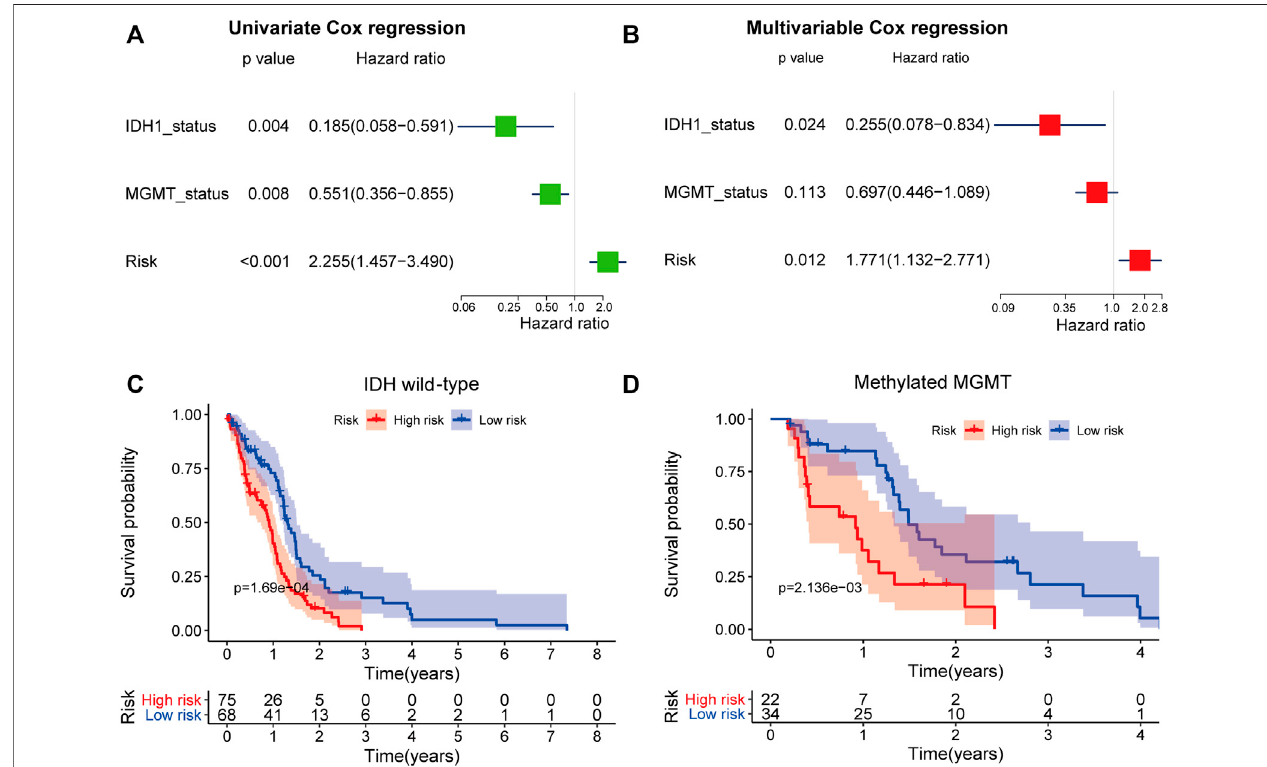
FIGURE 9 | The independence of the prognostic value of the fi ve-mRNA signature from molecular features. Univariate (A) and multivariate (B) Cox regression analysesofthecorrelation betweenGBM patientoverall survival(OS)and clinicalcharacteristics (IDH1mutationand MGMT promotermethylation status). Kaplan – Meier survival curve analysis of OS in the high- and low-risk groups for patients with IDH wild type (C) and methylated MGMT status (D) .